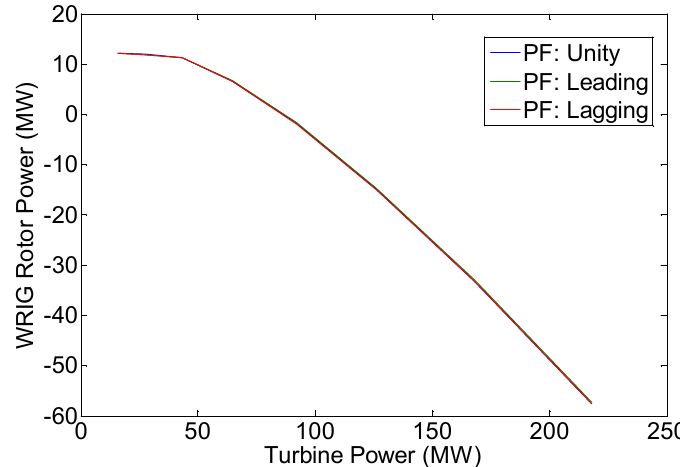
Figure 6. Variation of WRIG stator power ( P S ).